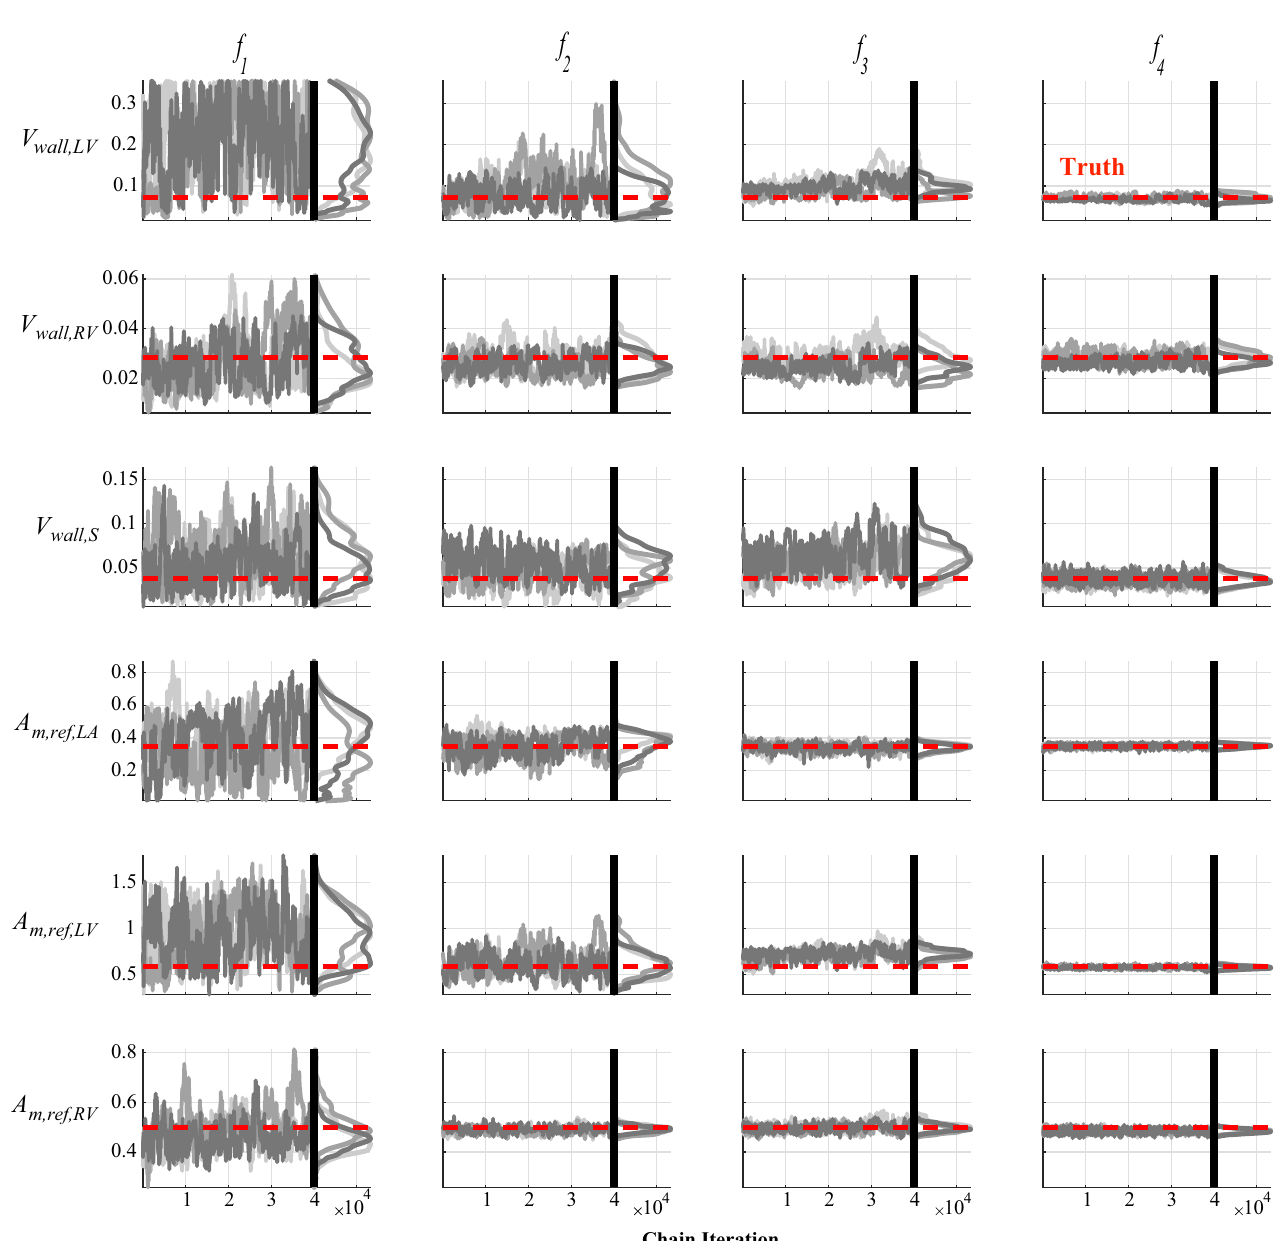
Fig 6. Chain iterations and marginal posteriors after MCMC for the TriSeg parameters. The model parameters indicative of the TriSeg geometry (wall volume, V , and reference mid-wall area, A ) are shown for each experimental design, corresponding to each column. The true, data generating wall m , ref parameters corresponding to the outputs in Fig 2 are shown as red lines. Three of the twelve initializations of MCMC are shown in different shades of gray. The marginal posterior distributions for the simplest experimental design ( f 1 ) are much wider than the subsequent more informed experimental designs, suggesting an improvement in practical